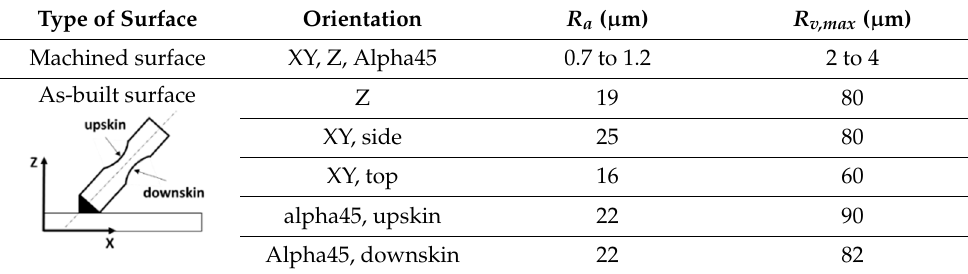
Table 3. Surface roughness measurements (3 measurements per sample).